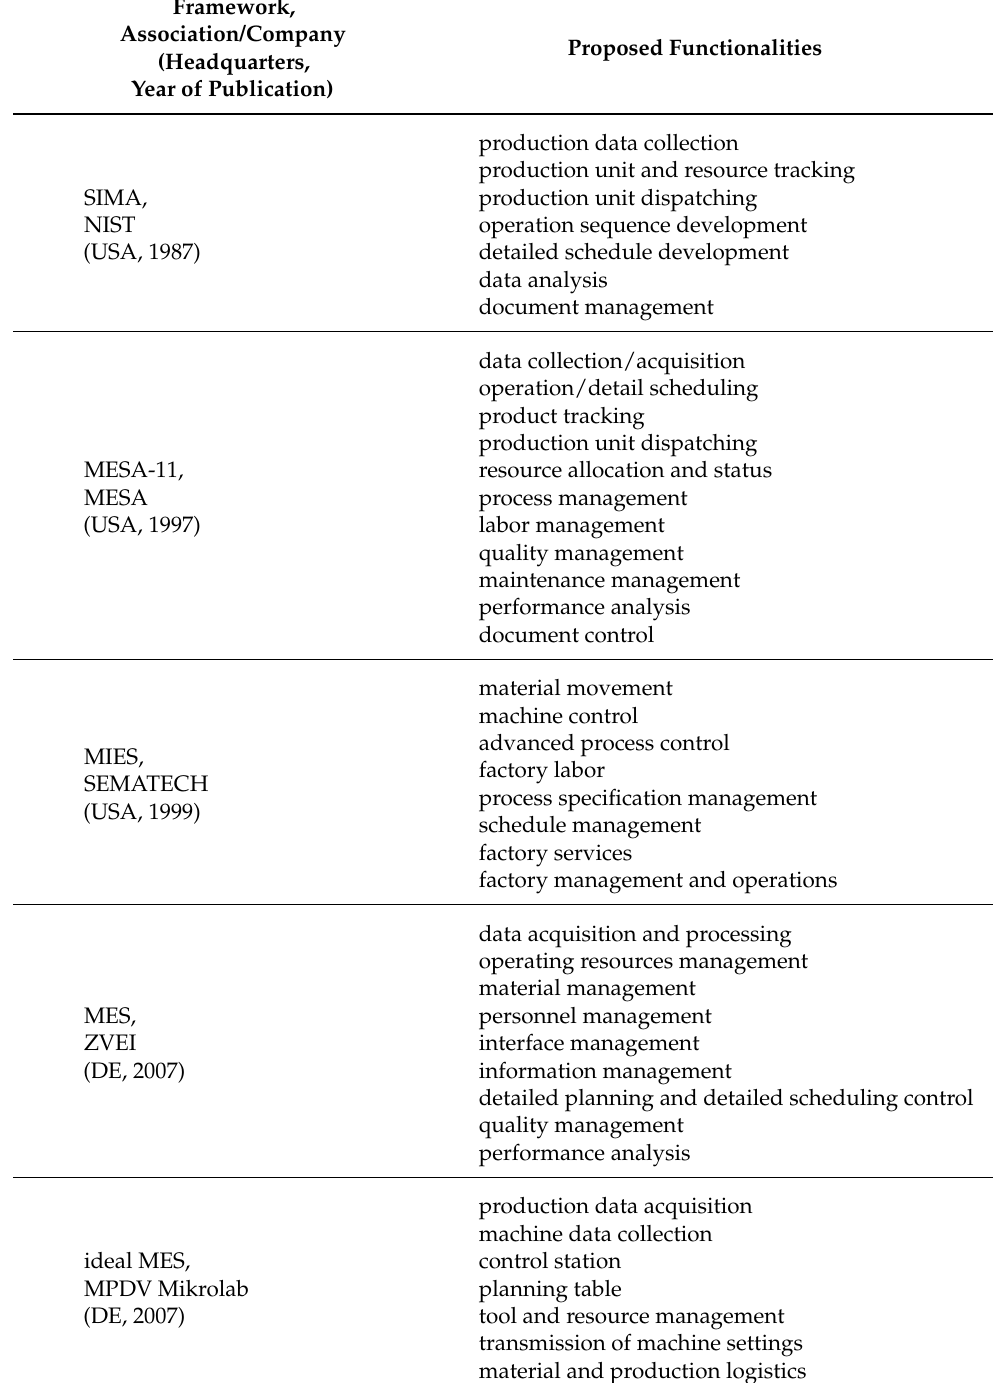
Table 1. List of major functional requirements of the Manufacturing Execution